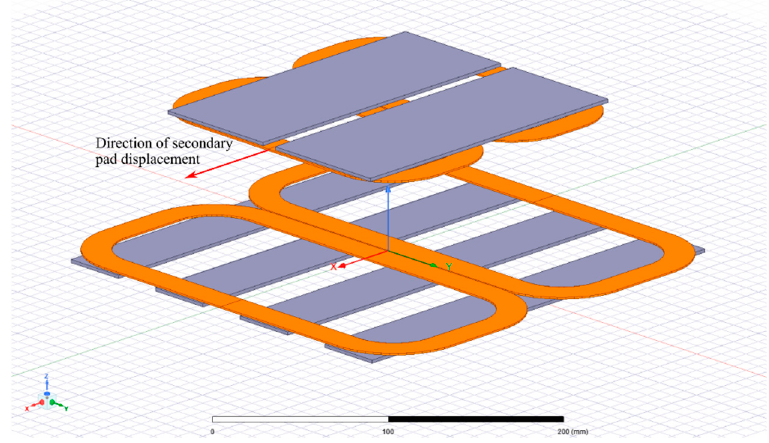
Figure 6. Secondary pad displacement in x axis.